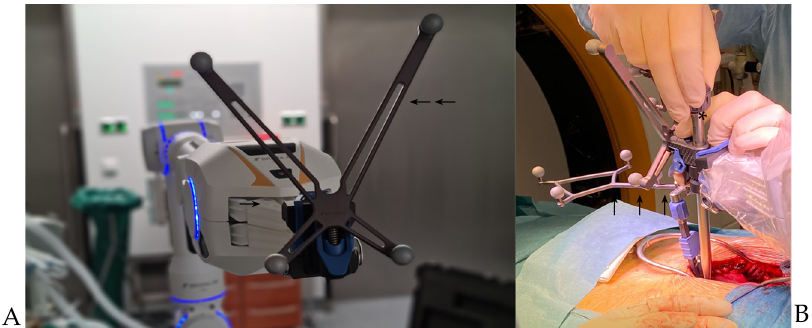
Figure 5. CIRQ Robotic Alignment Module. ( A ). Kinematic unit (arrow), tracking array (double arrow). ( B ). Intraoperative view. Attachment of drill guide (star) onto the kinematic unit. Reference array attached to the spinous process (triple arrow).